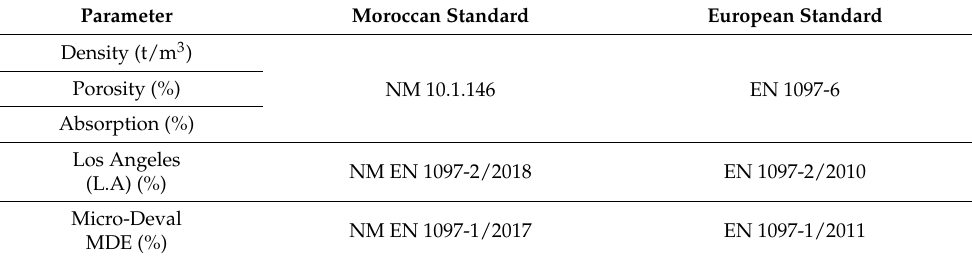
Table 2. Geotechnical testing.